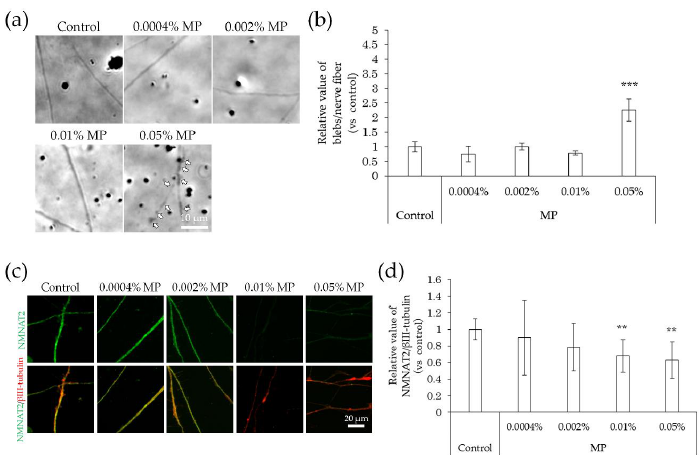
Figure 7. Effects of MP treatment on bleb formation and NMNAT2 expression in nerve fibers. After culturing for 3 days, the effects of the direct interaction between hiPSC-SN and MP were assessed. ( a ) Morphological changes in nerve fibers 24 h after treatment with MP. The arrows indicate blebs. ( b ) The number of blebs at various concentrations of MP. *** p < 0.001 vs. absence of MP (Dunnett’s test). ( c ) Double labelling of NMNAT2 (red) and βIII-tubulin (green) in nerve fibers at various concentrations of MP. ( d ) NMNAT2-immunoreactive (ir) nerve fiber length normalised to βIII-tubulin-ir nerve fiber length in identical areas at various concentrations of MP. ** p < 0.005 vs. absence of MP (Williams’ test). Each value represents the mean ± standard deviation of more than three wells. MP: methylparaben; NMNAT2: nicotinamide mononucleotide adenylyltransferase 2.